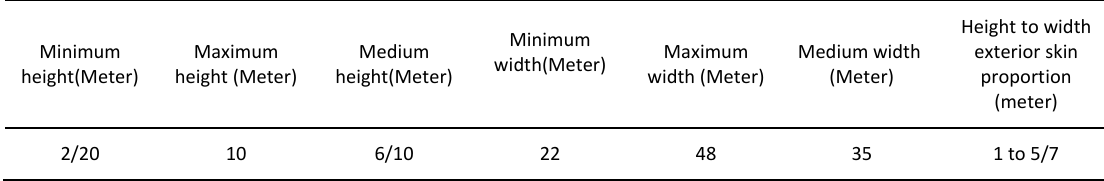
Table 4: Proportions of Yazd district Square exterior skin